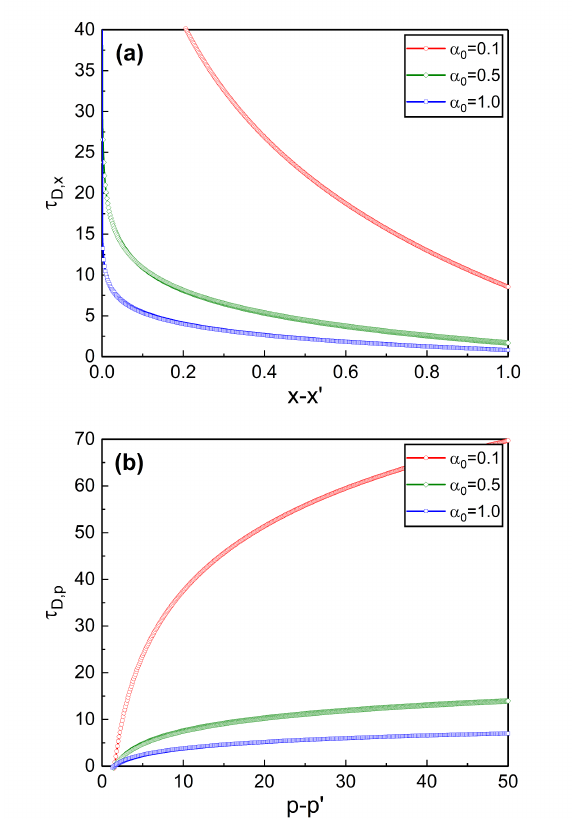
Figure 2. Decoherence time τ D , x ( a ) given in Equation (77) and τ D , p ( b ) in Equation (79) for the damped harmonic oscillator plotted as a function of x − x (cid:48) and p − p (cid:48) respectively. The values taken here are given by ¯ h = 1, k = 1, Ω 0 = 1, m 0 = 1, T = 1, and ϕ =